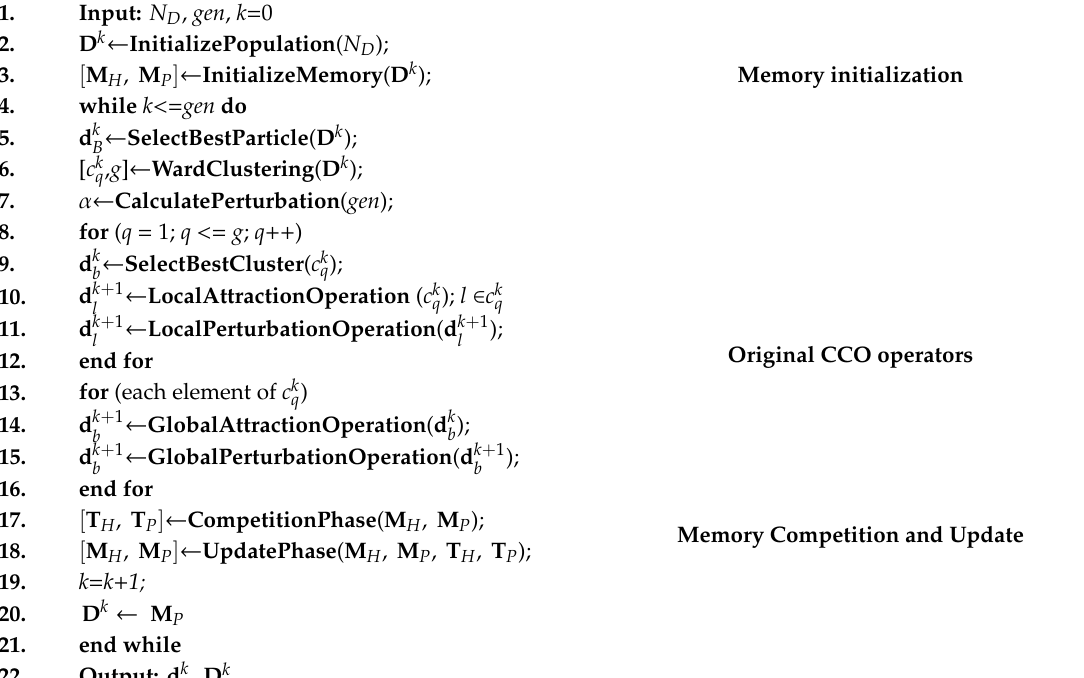
Algorithm 4. Pseudo-code for the Multimodal Cluster-Chaotic-Optimization (MCCO)